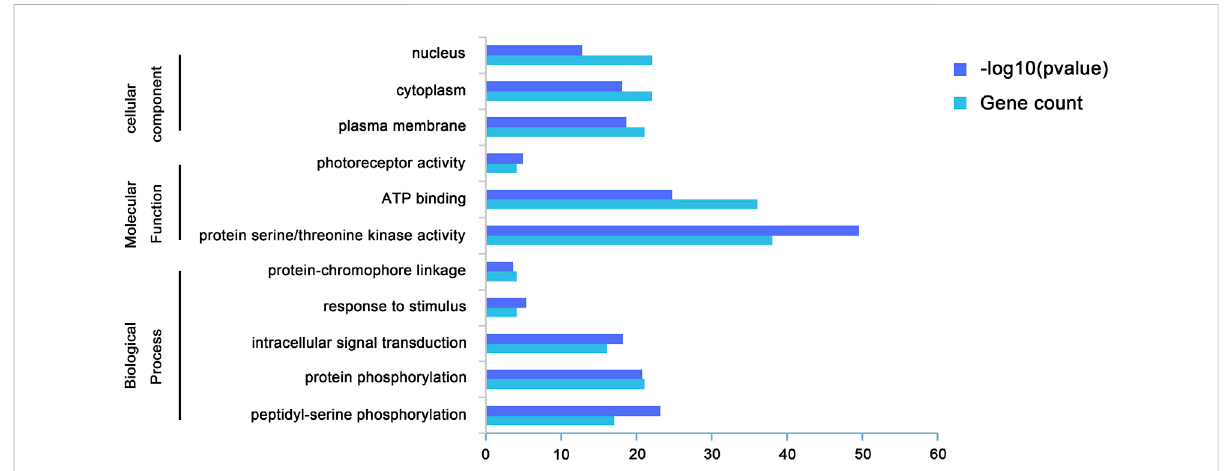
FIGURE 3 Gene Ontology of BrAGC genes in molecular function, biological process, and cellular component